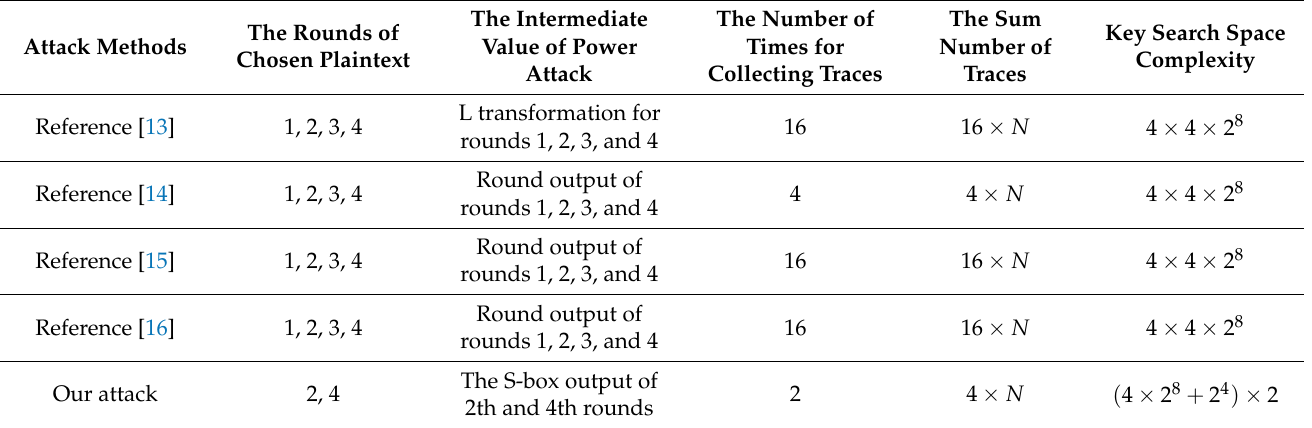
Table 1. Comparison of four attack methods’